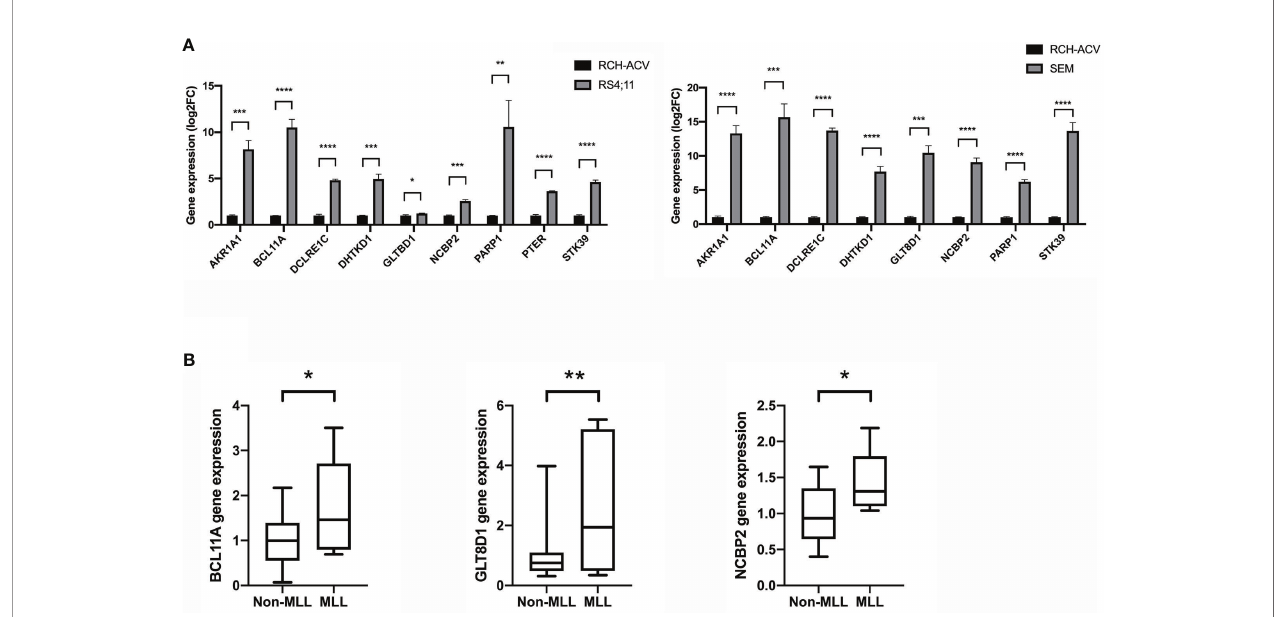
FIGURE 7 | The gene expression level of key hub genes in MLL -r ALL and non- MLL -r ALL patients. (A) The mRNA expression of key hub genes were measured in RS4:11, SEM, and RCH-ACV cell lines. Data are normalized to b -actin and are representative of three independent experiments (* p < 0.05; ** p < 0.01; *** p < 0.001;